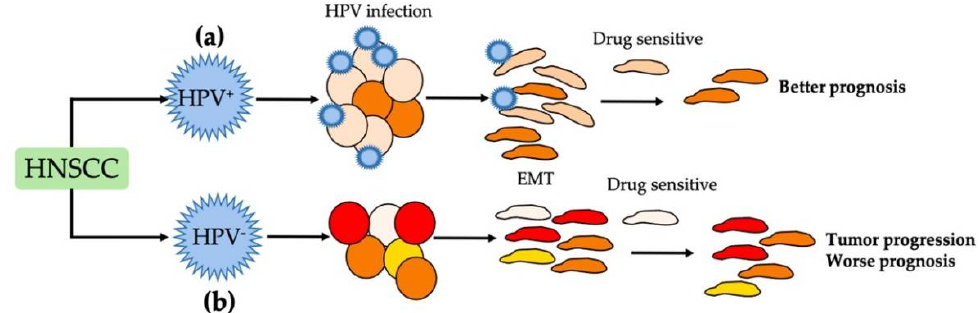
Figure 3. ( a ) HNSCC cells infected with HPV induce tumor homogeneity associated with sensitivity of treatment and better prognosis. ( b ) HNSCCs not infected with HPV show tumor heterogeneity related to treatment resistance and worse